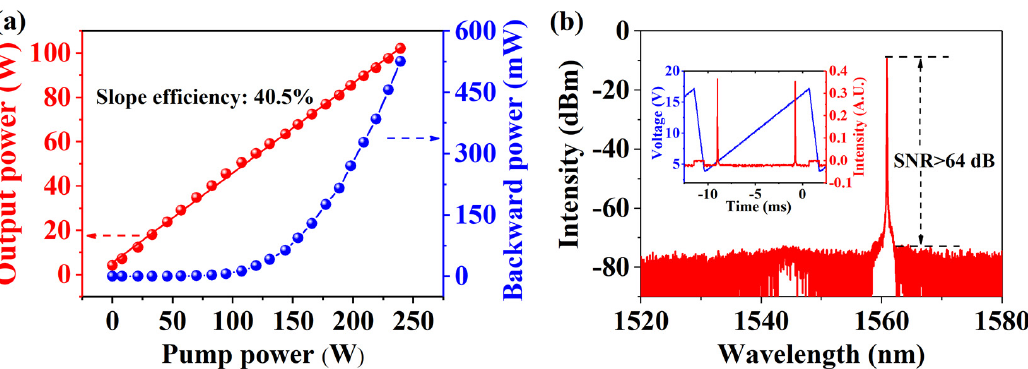
Figure 4. The system is under 940 nm LD pumping and 6 W input signal power. ( a ) The output power and the backward power of the 1560 nm high-power linearly-polarized SFFL versus the pump power. ( b ) The optical spectrum of this 1560 nm linearly-polarized SFFL at the maximum output power. Inset: Longitudinal mode characteristic of this 1560 nm linearly-polarized SFFL at maximum output power.